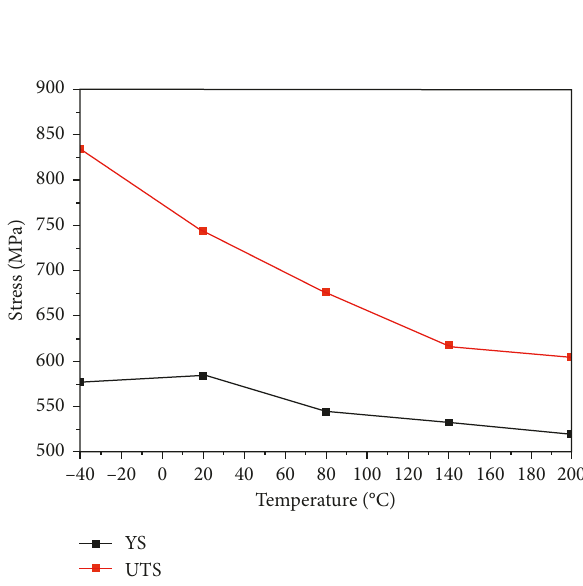
Figure 3: True stress-true strain curves in a uniform elongation range of the X6MnSiAlNbTi26-3-3 steel at various deformation temperatures.